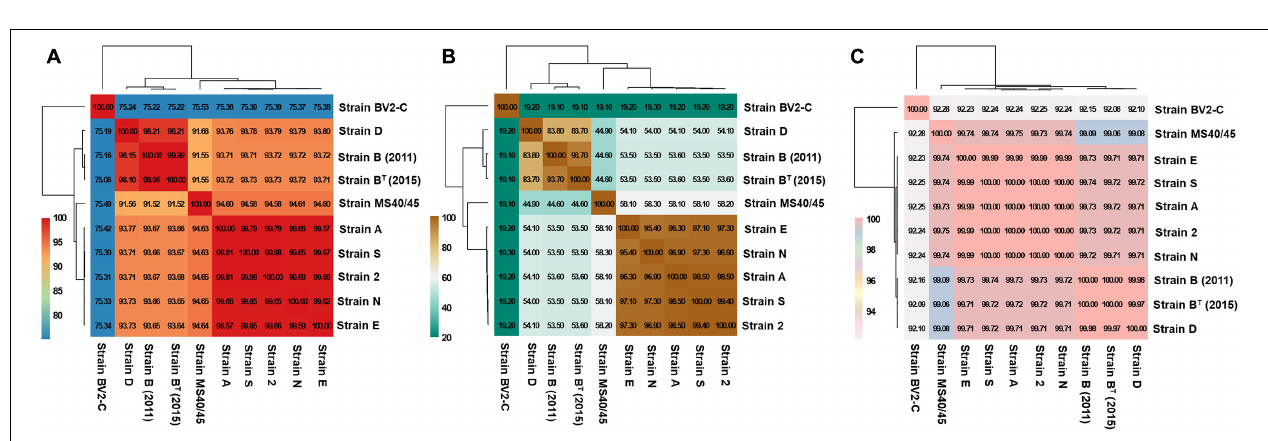
FIGURE 2 | Multiple sequence alignments calculated by MAUVE. Global multiple sequence alignments of ten Chloracidobacterium spp. genomes to evaluate synteny, large-scale rearrangements, and inversions. Sequences from 1 to about 2.6 Mbp correspond to chromosome 1 and sequences covering the last ∼ 1.0 Mbp correspond to chromosome 2. A thin, vertical red line marks the junction of chromosomes 1 and 2.